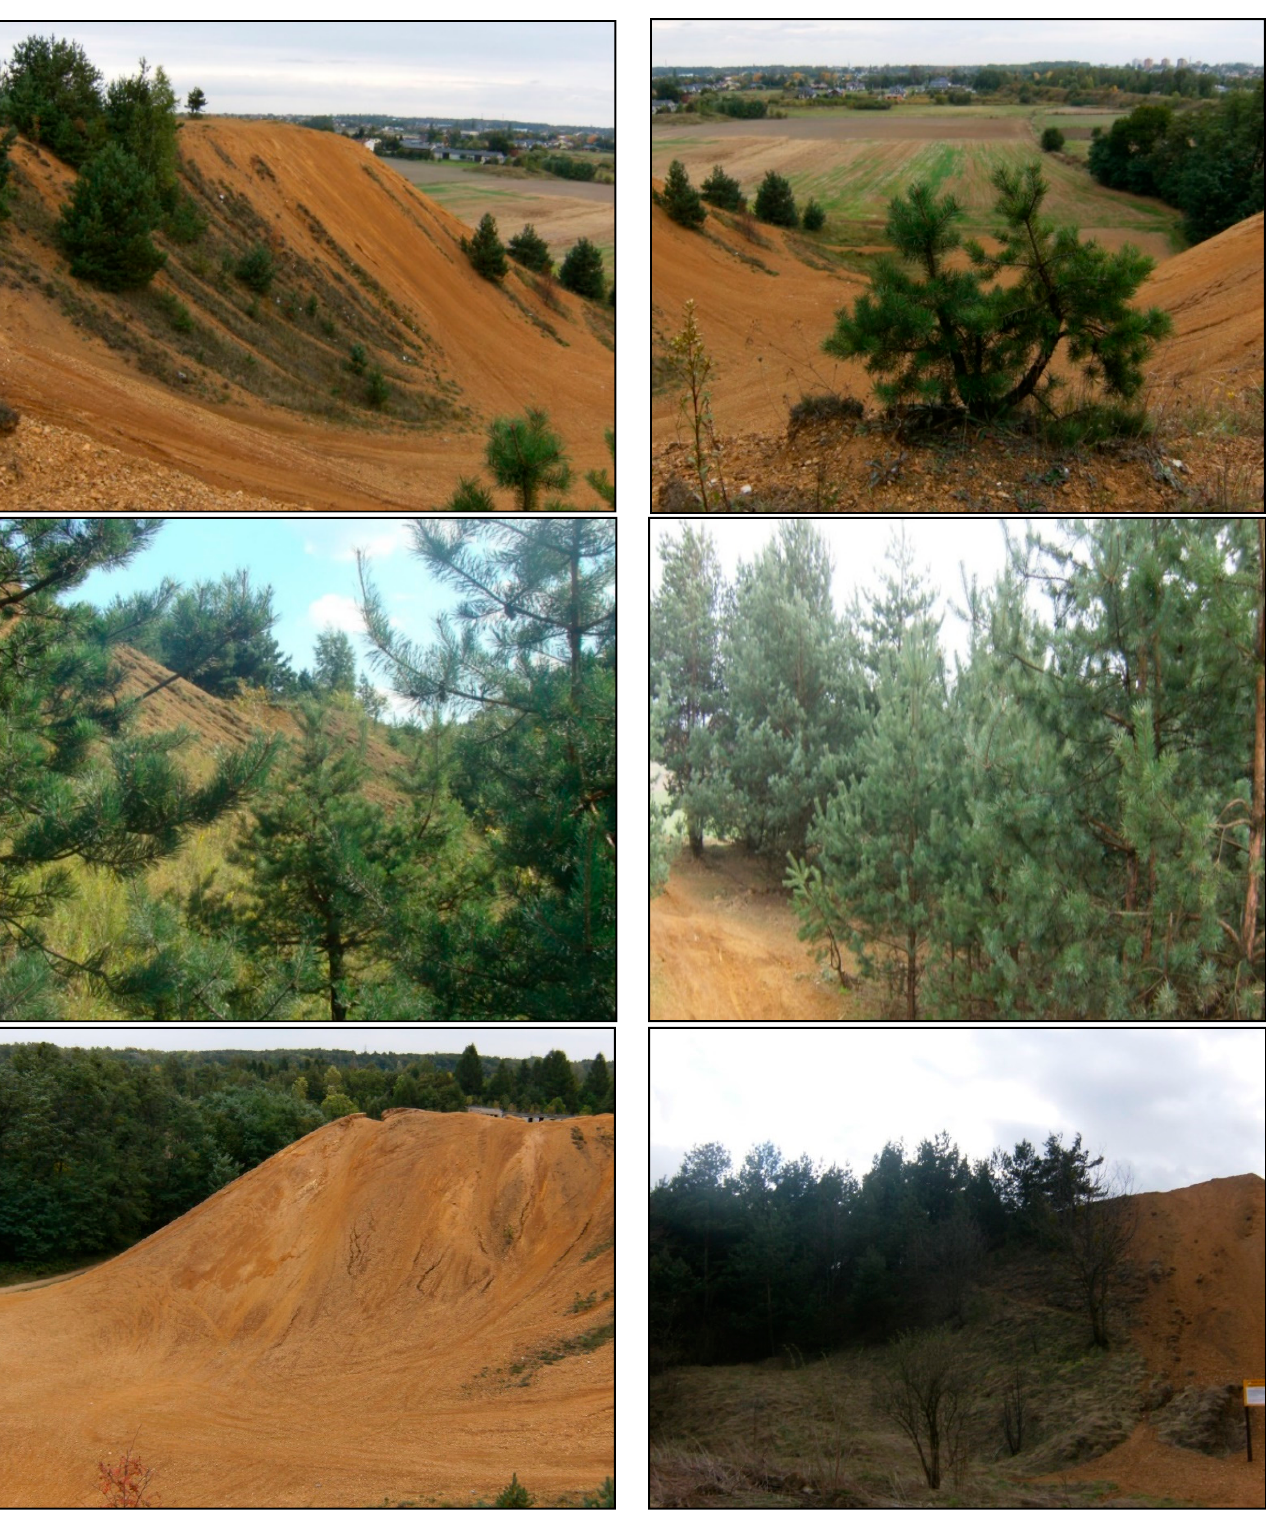
Figure 2. The spoil heap of “Fryderyk” mine in Tarnowskie Góry—examples of the forest succession process.